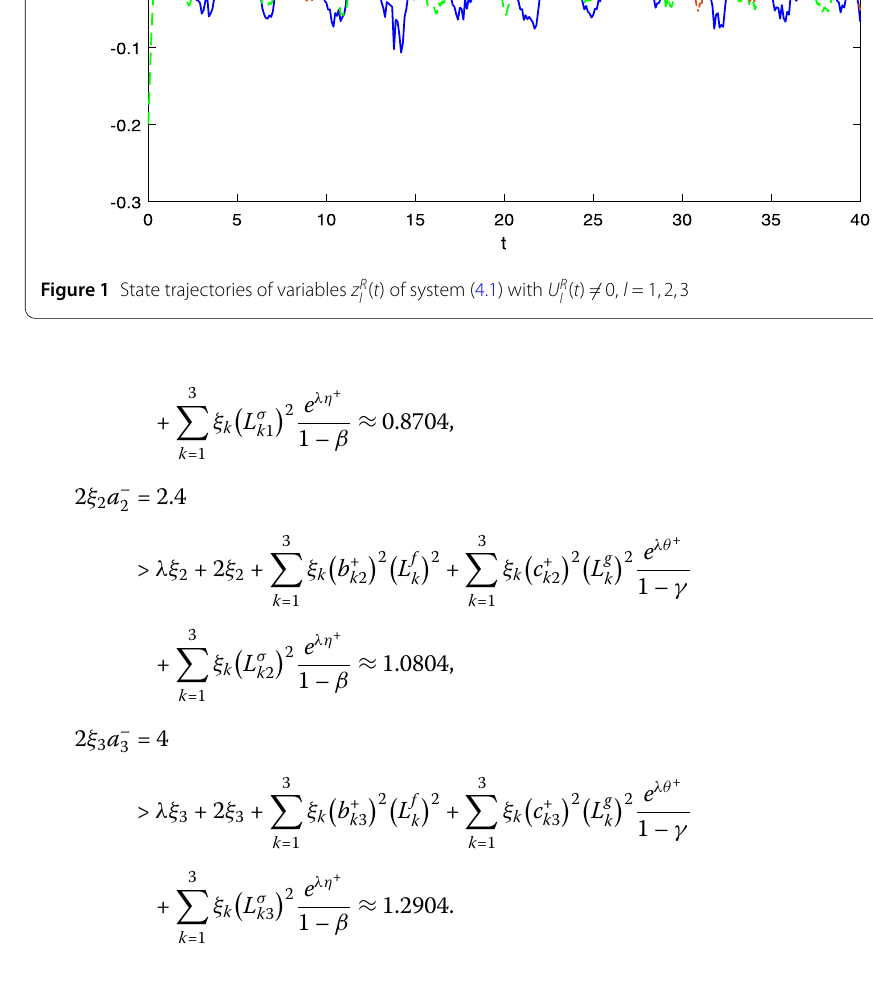
Figure 1 State trajectories of variables z R